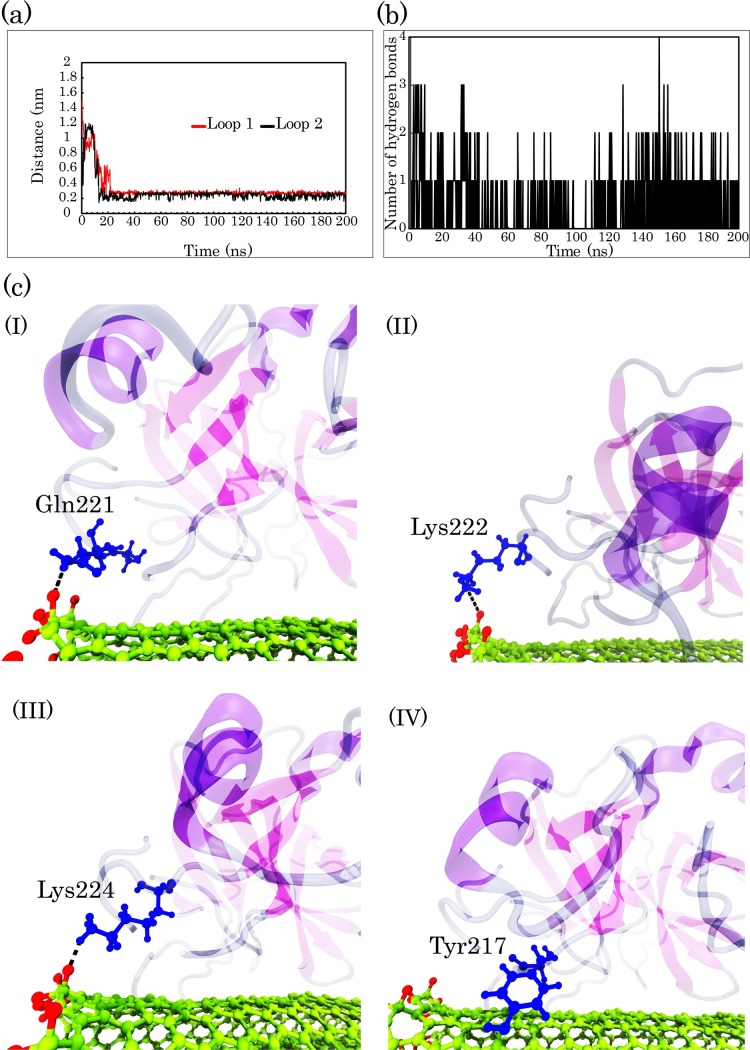
MD simulations indicate interaction between COOH-f-DWCNT and S1 pocket of the enzyme.(a) Minimum distance between Loop 1 and Loop 2 of S1 pocket with COOH-f-DWCNT in system 1 over the simulation time (for analysis of minimum distance between Loops with COOH-f-DWCNT in system 3, refer to the supplementary information). (b) The number of hydrogen bonds between S1 pocket and COOH groups of COOH-f-DWCNT in system 1 as function of time. (c) Local snapshots from hydrogen binding interaction by (I) Gln-221, (II) Lys-222, and (III) Lys-224 and π-π stacking interaction by (IV) Tyr-217.